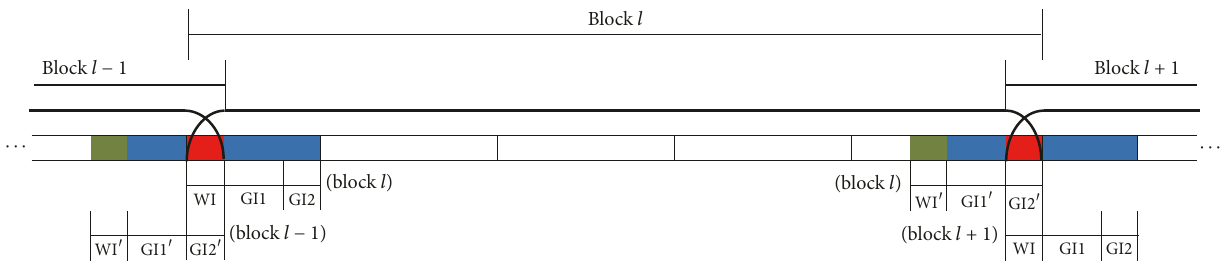
Figure 9: Overlapping between adjacent WCP-COQAM blocks and CP extension’s structure. Only GI1 and GI1 󸀠 remain equal in order to emulate a circular convolution with the channel and perform frequency domain equalization, so GI2 implies an overload that affects